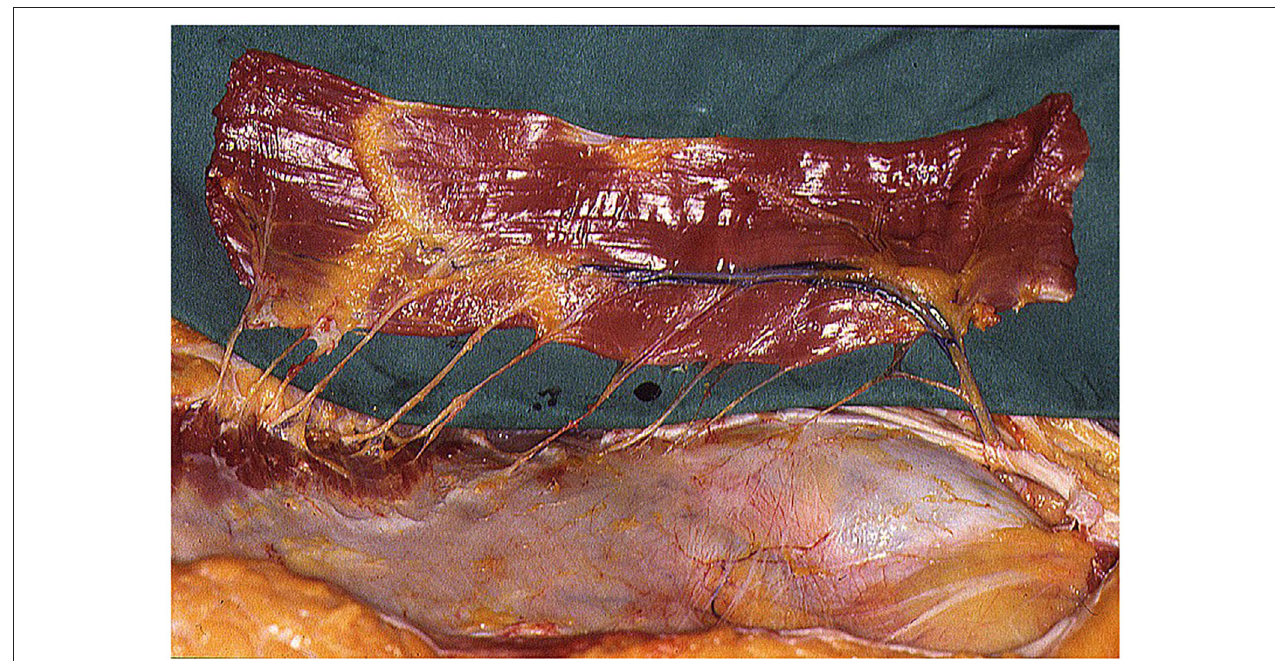
FIGURE 3 | Fresh cadaver dissection shows innervation and blood supply of rectus abdominis muscle.